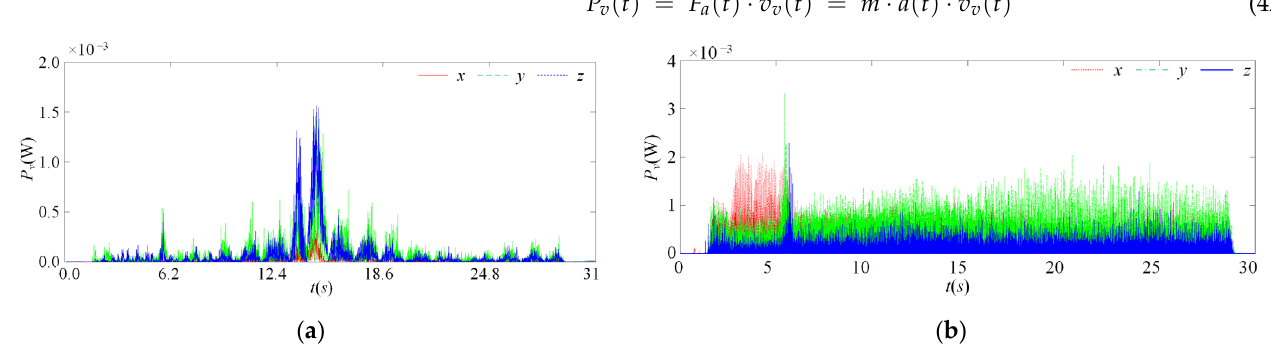
Figure 23. Input energy of milling vibration of scheme 1 and scheme 2. ( a ) scheme 1; ( b ) scheme 2.